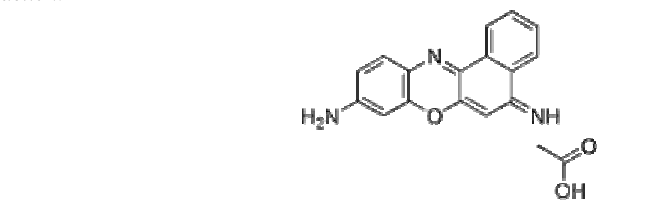
Figure 2. Structure of Cresyl